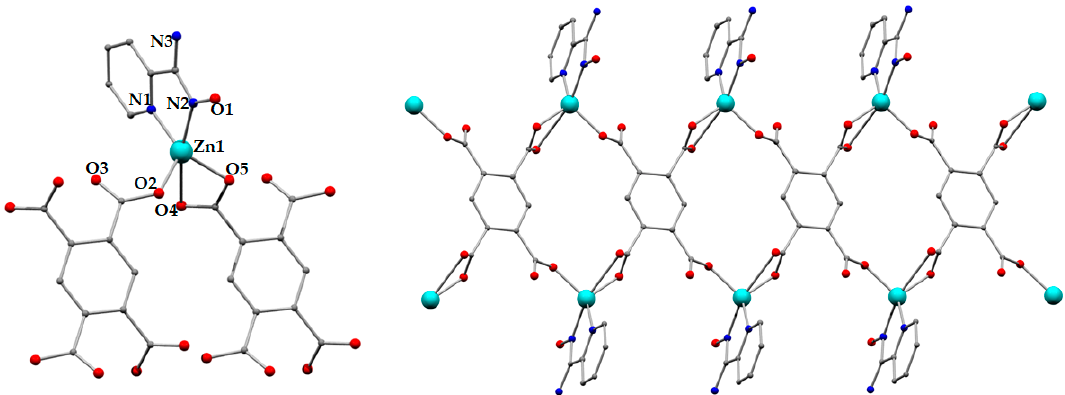
Figure 2. Representation of the repeating unit ( left ) and a part of the 1D double chain of 2 ( right ). Color code: Zn, cyan; N, navy blue; O, red; C, grey. The hydrogen atoms are omitted for clarity.